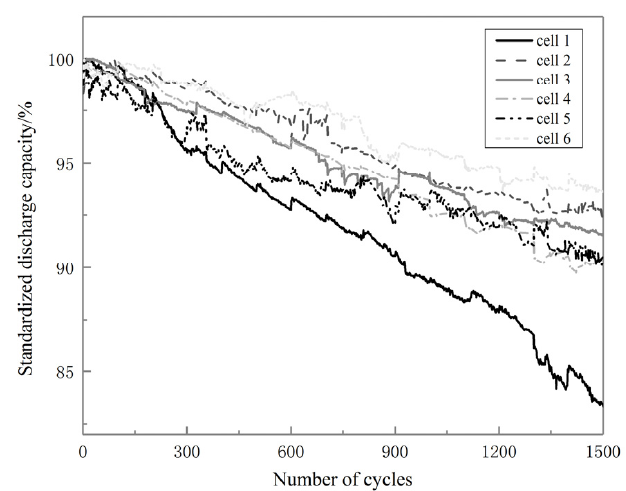
Figure 3. Capacity-fade performance of six cells.